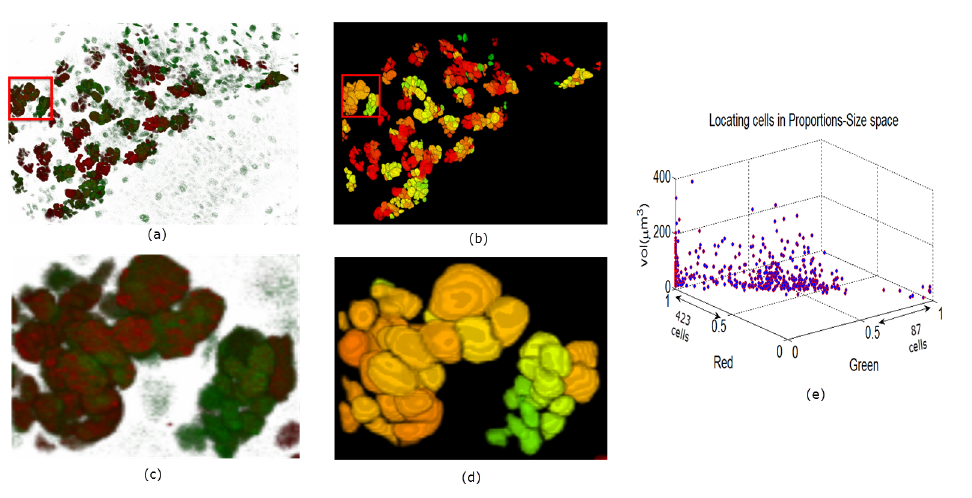
Figure 10. Panel ( a ) is a depiction of a MUTANT TYPE larval brain nuclei in 3D volume in ZEN. In panel ( b ), the 3D segmentation is visualized in ImageJ. In panels ( c ) and ( d ) enlarged regions are shown from the original and reconstructed images. Panel ( e ) similarly shows the quantitative description of the cells.